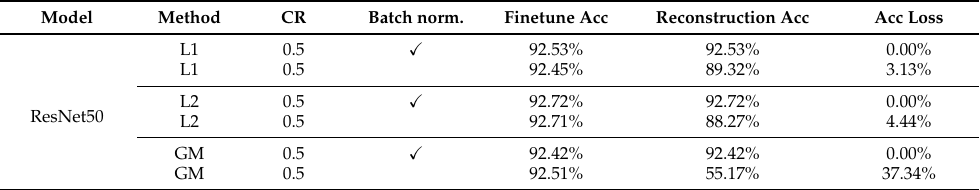
Table 8. Results of ResNet50 with a compression rate of 0.5 on the CIFAR10 dataset. In the “Batch norm” column, “ (cid:88) ” indicates pruning of the batch normalization layer corresponding with the convolution layer. The “Finetune Acc” column denotes accuracy after retraining the pruned model, while the “Finetune Acc”, “Reconstruction Acc”, and “Acc Loss” columns have the same meaning as in Table 7.